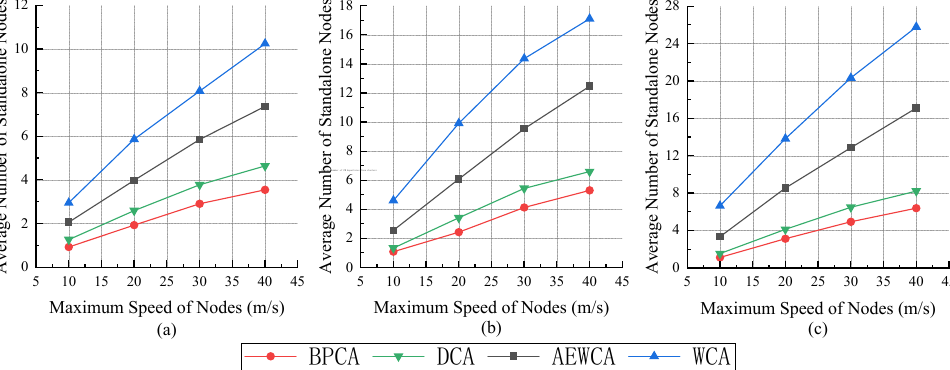
Figure 9. The effects of maximum movement speed on the average number of standalone nodes. ( a ) Number of nodes is 100; ( b ) number of nodes is 150; ( c ) number of nodes is 200.